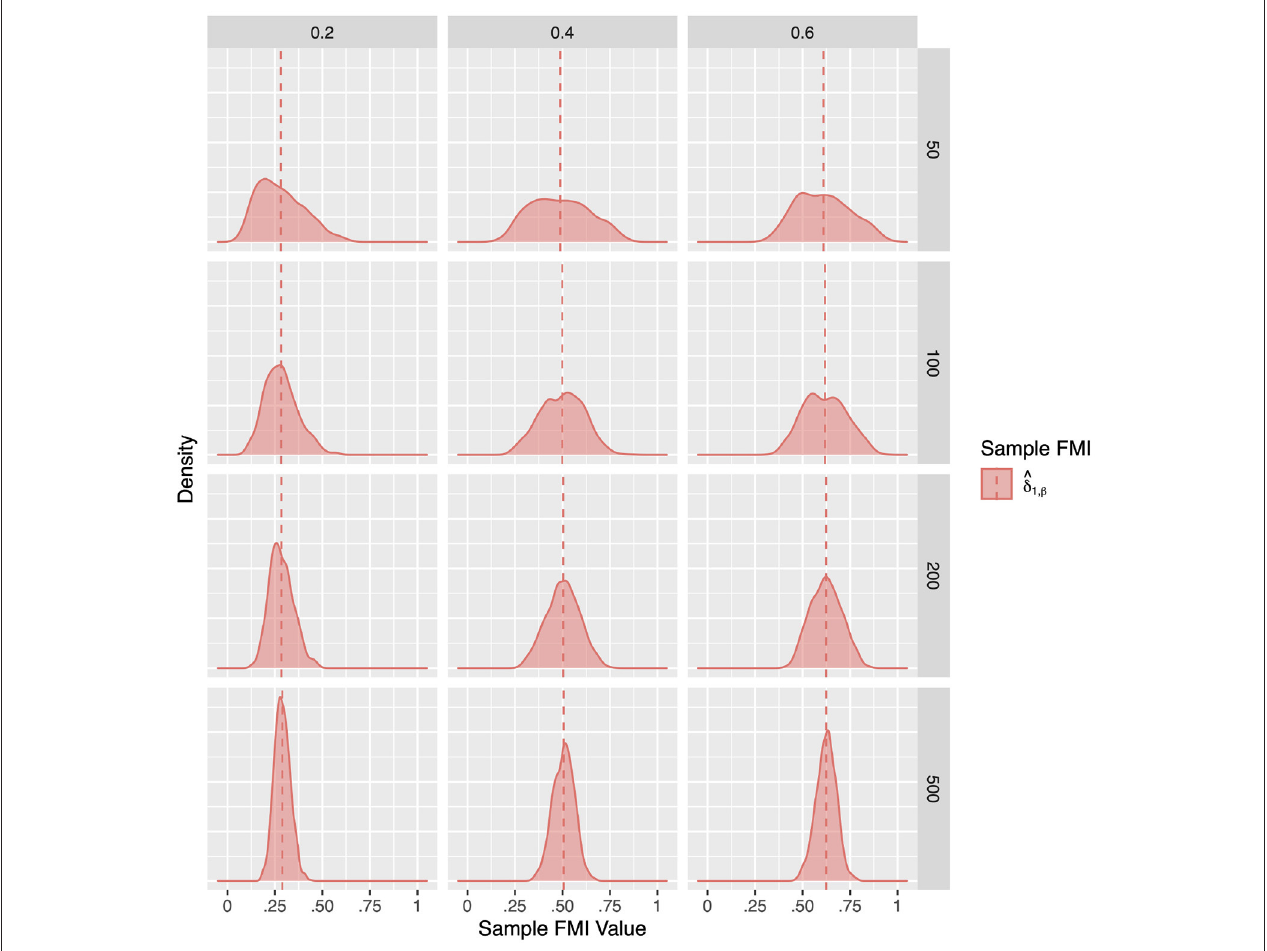
FIGURE 2 | The sampling distribution of FMI for regression coefficients in linear MAR. The panel rows correspond to sample sizes of N panel columns correspond to per variable missing rates of 20, 40, and 60, or overall population missing rates of 10, 20, and 30%. The population FMI value in each panel is given as a vertical black dotted line. The sampling distributions of the three estimates are virtually identical in simple